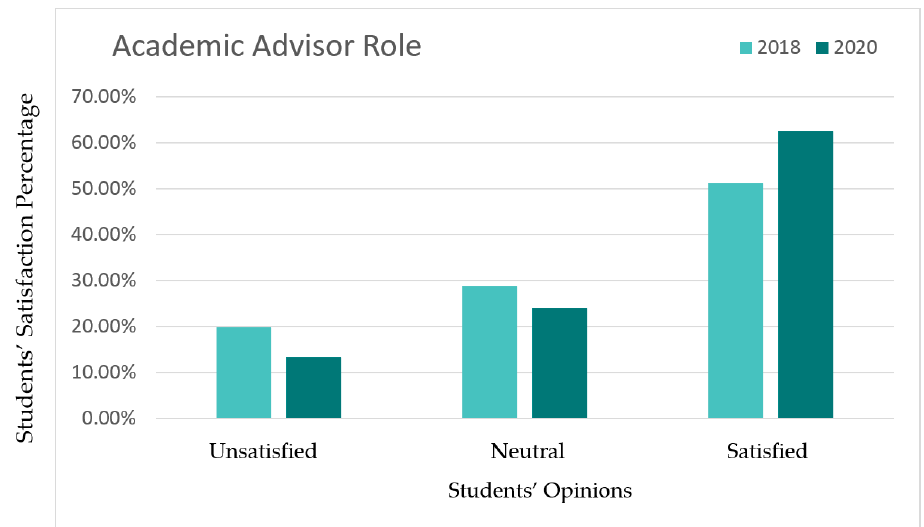
Figure 6. Student trends for academic advisors in 2018 and 2020.